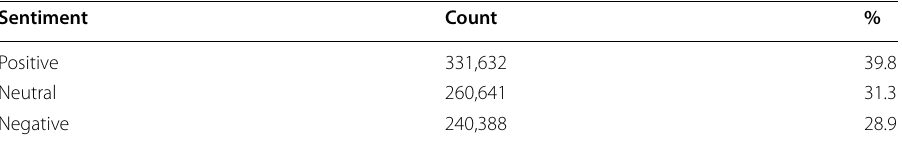
Table 4 Diagram showing the frequency distribution of sentimental analysis using VADER